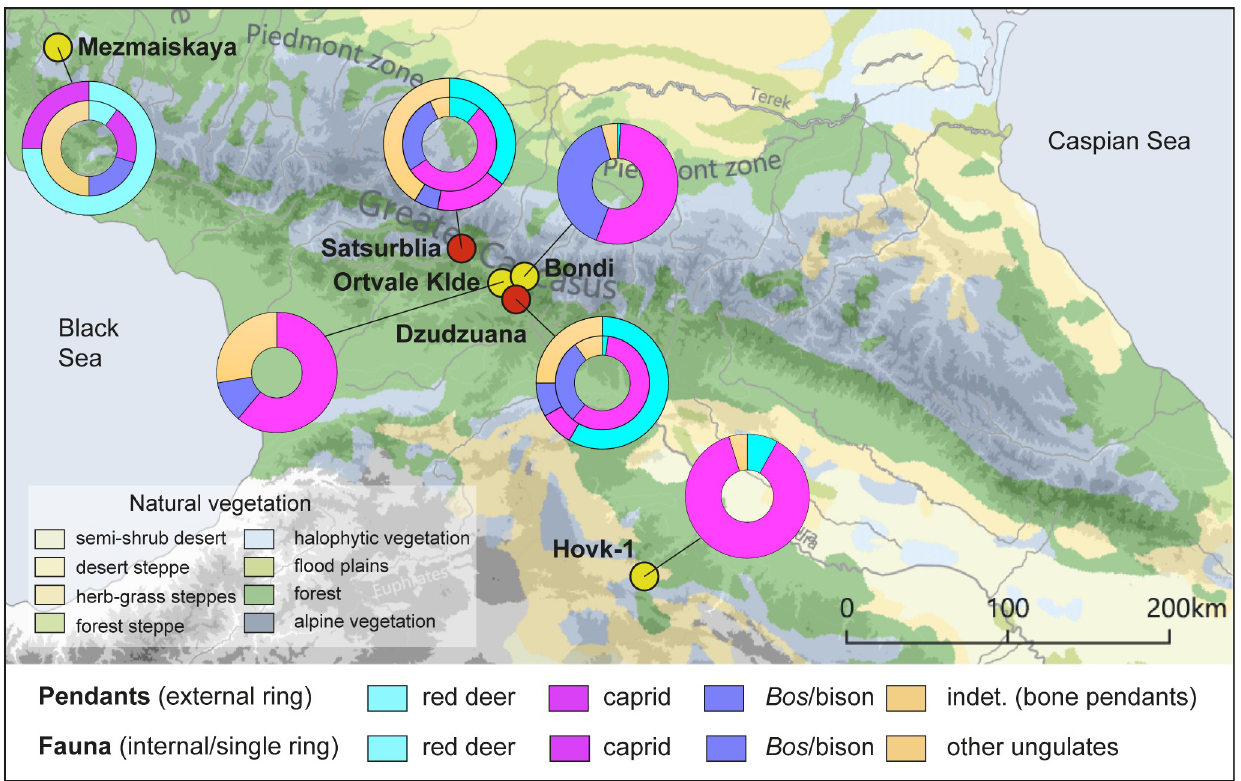
Fig 8. Map of the Caucasus with UP sites and distribution of raw material of the pendants. Dzudzuana, Satsurblia, Mezmaiskaya (external rings), and faunal remains (internal rings). Faunal data after: [2, 11, 17–19, 27, 28]. Background map after Stone, T.A., and P. Schlesinger. 2003. RLC Vegetative Cover of the Former Soviet Union, 1990. ORNL DAAC, Oak Ridge, Tennessee, USA. This dataset is openly shared, without restriction, in accordance with the NASA Data and Information Policy.